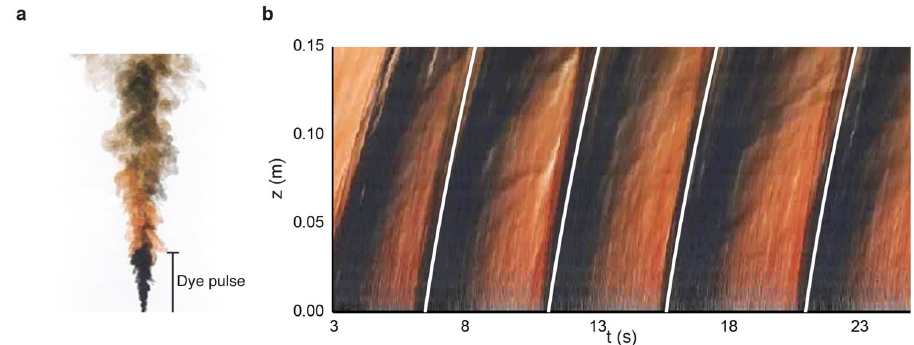
Fig. 2 Laboratory vertical plumes. a Photograph from an experiment of a turbulent saline plume in fresh water. b Time series of a vertical line through the centre of the plume, in which a series of pulses of dye were added to the plume. The white lines track the leading edge of each dye pulse as it rises through the plume, and these lines are given by Eq. (2).